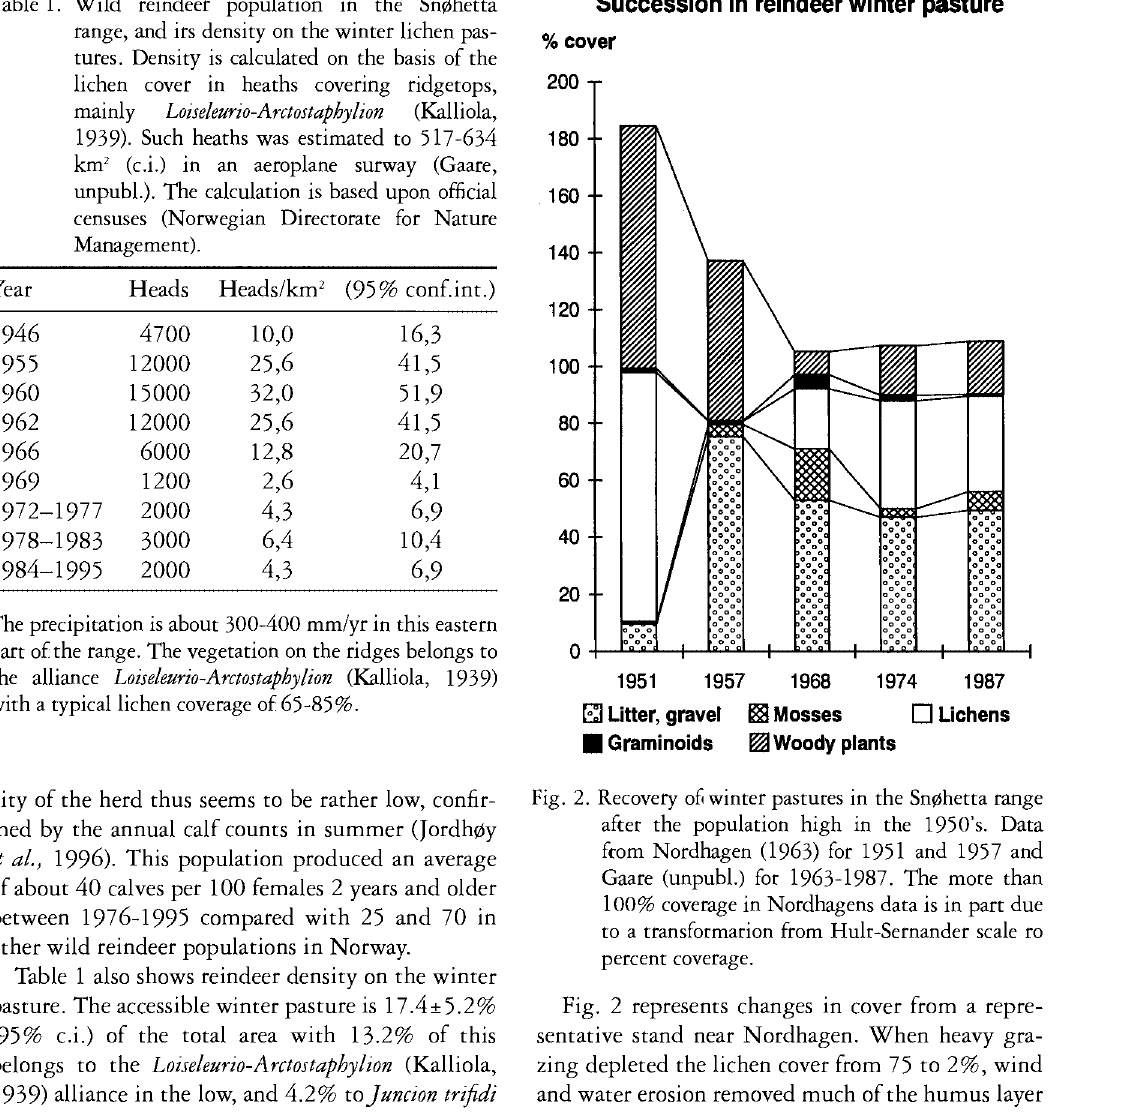
reindeer population in the Snøhetta